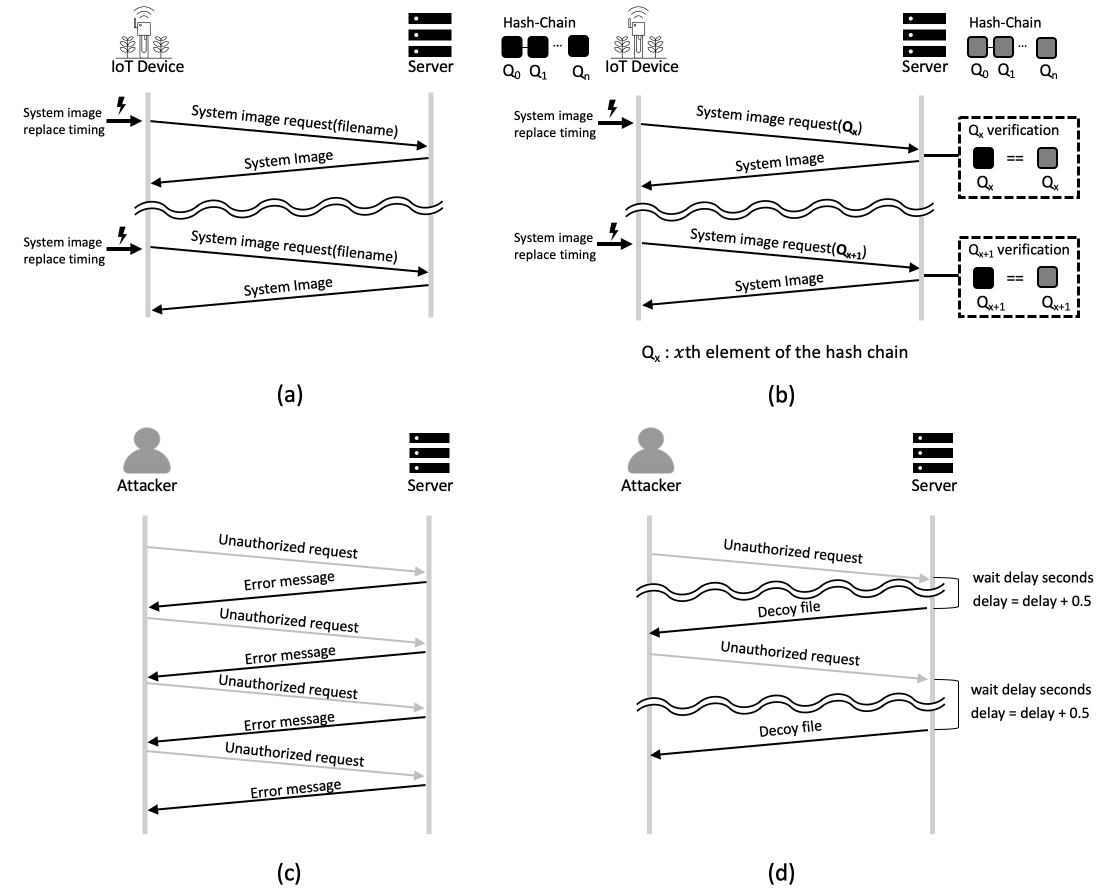
Figure 2. Trivial file transfer protocol (TFTP)-compatible file access control and attacker deception technique. ( a ) System image request and response of native TFTP, ( b ) system image request and response of TFTP-compatible file access control, ( c ) unauthorized file request and error message response of native TFTP, ( d ) unauthorized file request and the attacker deception